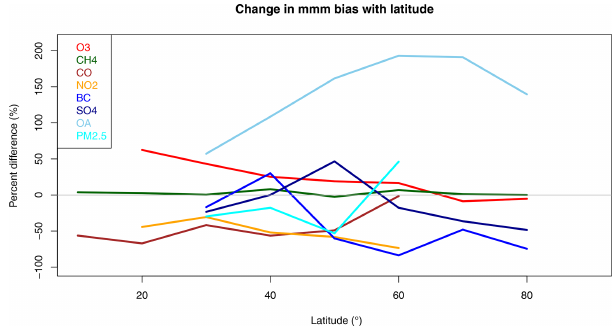
Figure 4. Multi-model mean percent biases for surface SLCF con- centrations versus latitude (in 10 ◦ latitude